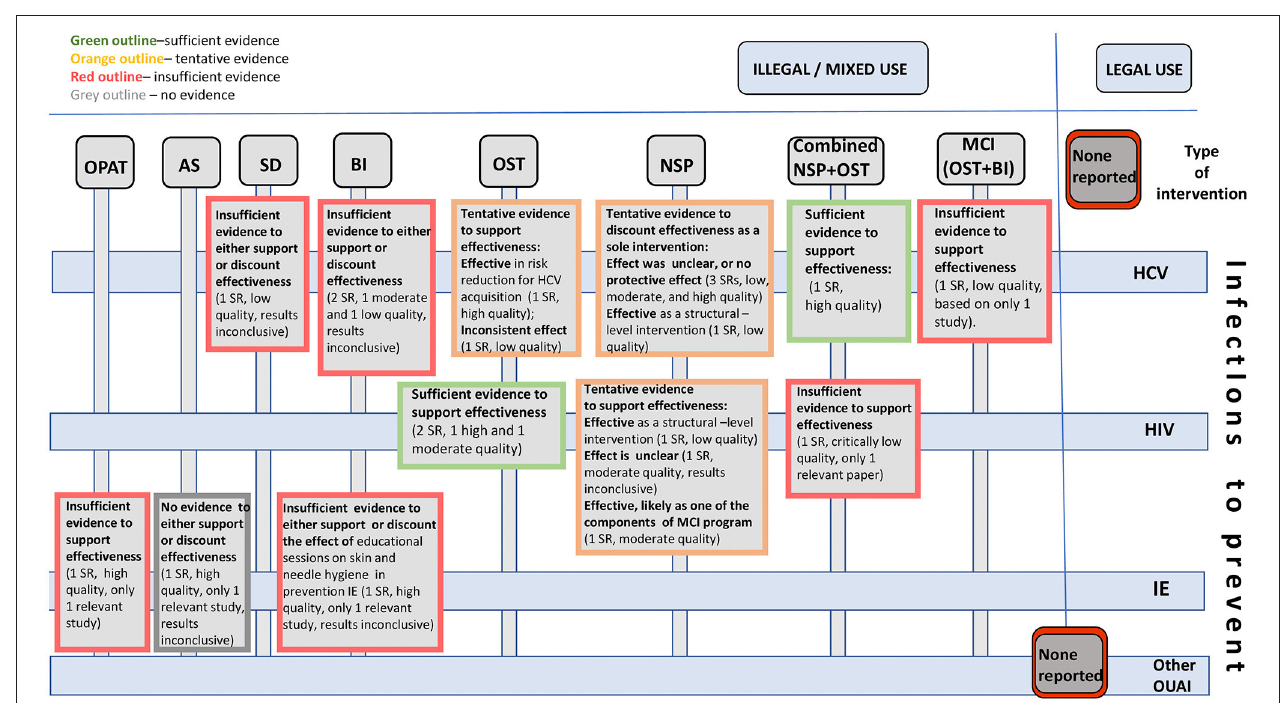
FIGURE 2 | Typology of interventions with reported effectiveness in prevention of common infections in opioid users.